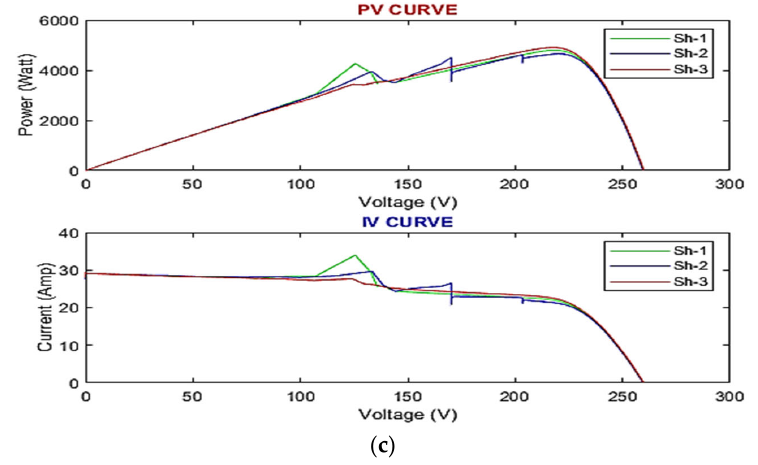
Figure 4. Impact of fault on TCT configuration. Open-circuit fault. ( b ) Short-circuit fault. ( c ) Shadowing fault.